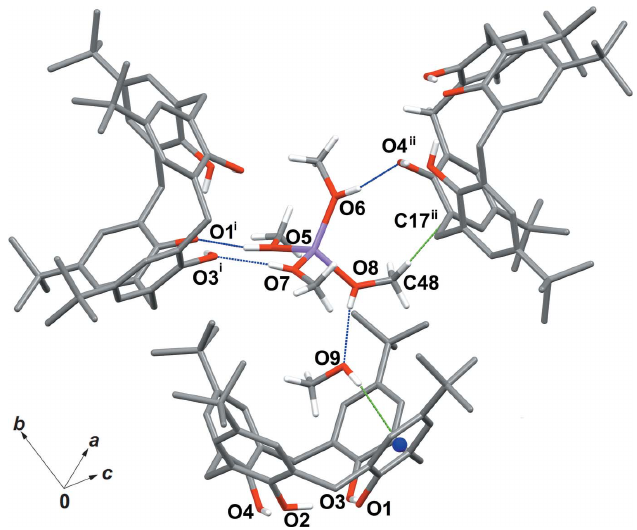
Figure 3 Hydrogen bonding (blue and green dotted lines) involving the [Li(CH 3 OH) 4 ] + complex and two adjacent calix[4]arene molecules in the crystal structure. [Symmetry codes: (i) 3 1 + z .] 2